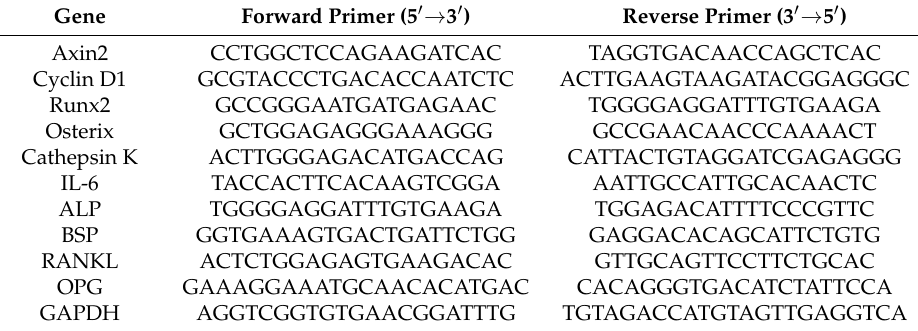
Table 1. Gene nomenclature and primer